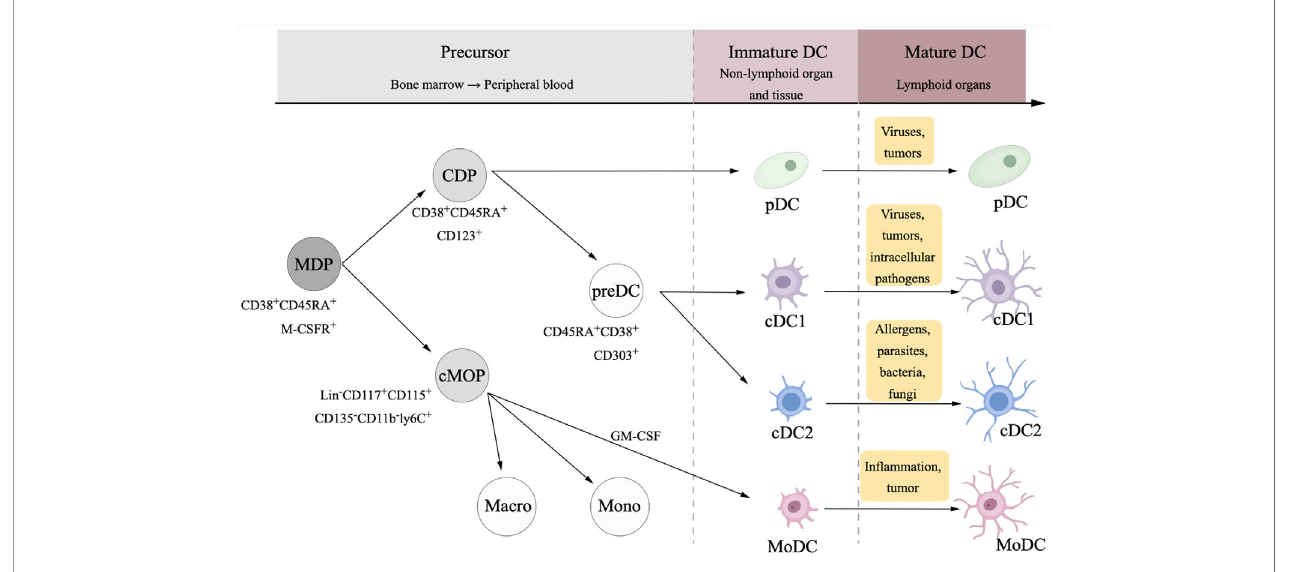
FIGURE 1 | Differentiation and maturation of dendritic cell (DC). DCs and monocytes originate from a common ancestor, namely macrophage dendritic cell progenitor (MDP). MDPs differentiate to common monocyte progenitors (cMOPs) and common DC progenitors (CDPs). cMOPs generally differentiate into monocytes and macrophages, while in some situations with pro-in fl ammatory context, cMOPs could be stimulated by granulocyte-macrophage colony stimulating factor (GM- CSF) then differentiate to monocyte-derived dendritic cells (MoDCs). CDPs differentiate to two subsets, plasmacytoid DCs (pDCs), and myeloid dendritic DCs, which is usually called conventional DCs